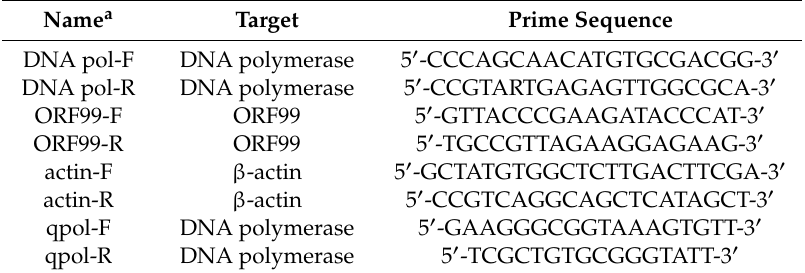
Table 1. Primer pairs used to detect CyHV-2 DNA and gene